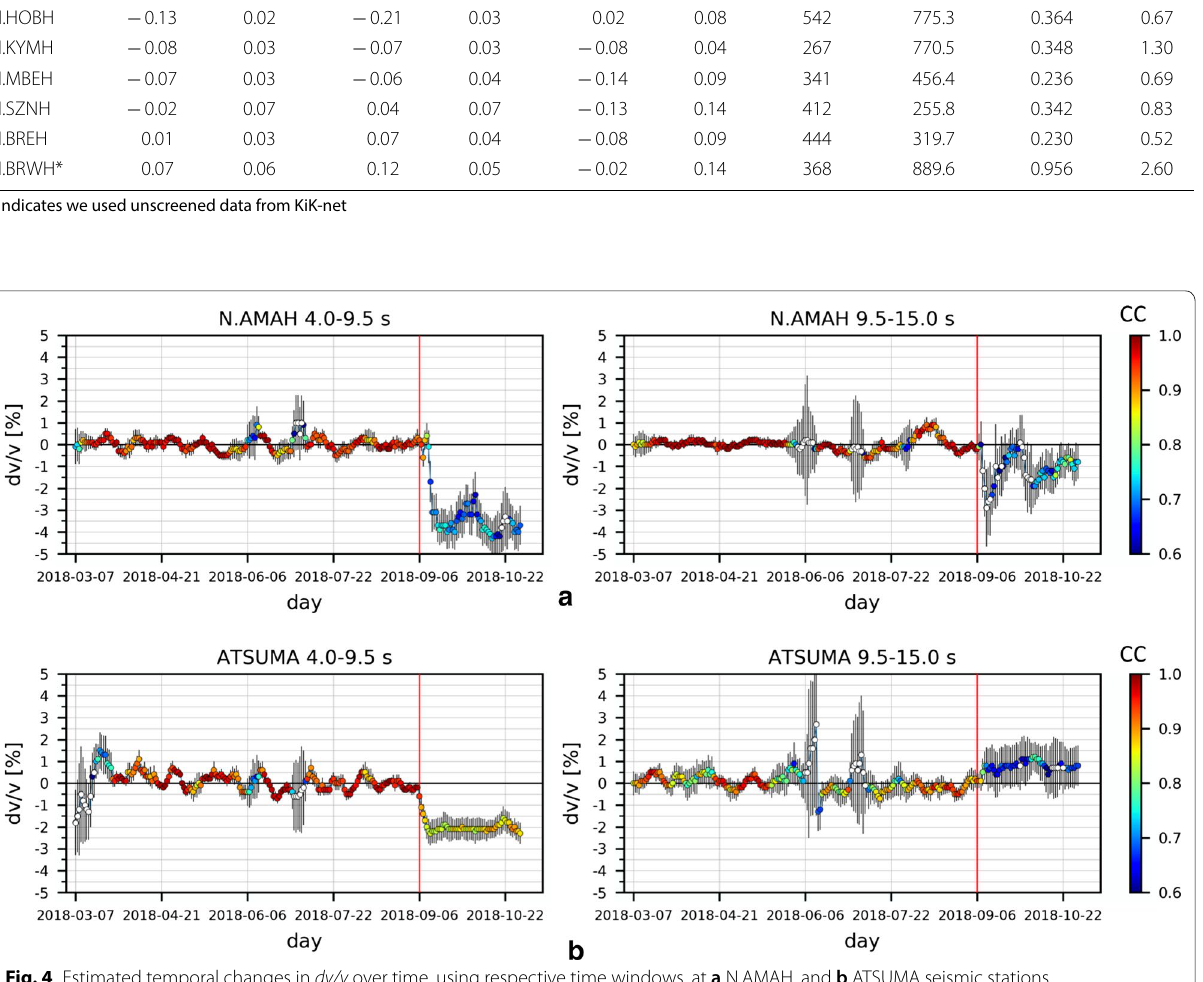
Fig. 4 Estimated temporal changes in dv/v over time, using respective time windows, at a N.AMAH, and b ATSUMA seismic